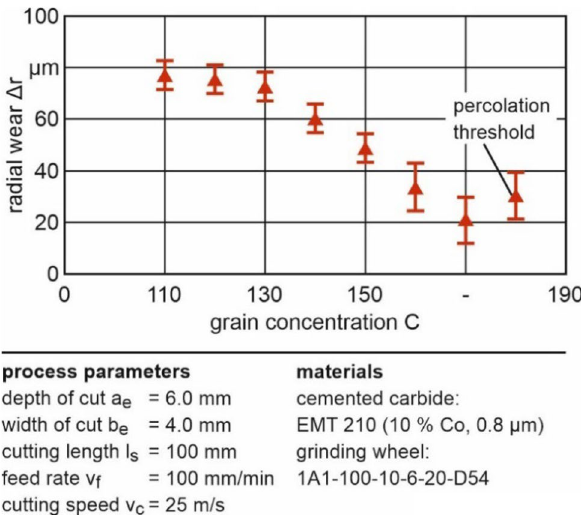
Fig. 7 Influence of grain concentration on radial wear